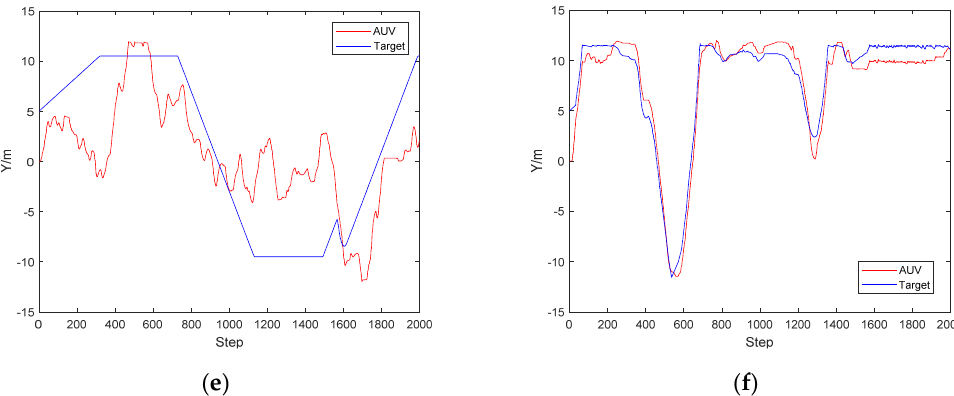
Figure 10. The coordinate change curves during the process of AUV tracking the target using PPO, GAIL, and MAG, respectively, training 20,000 times in Scene 1: ( a – c ) the X-coordinate change; and ( d – f ) the Y-coordinate change.